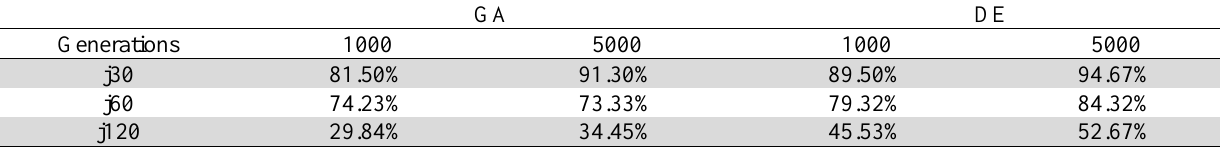
Success rates for j30, j60, and j120